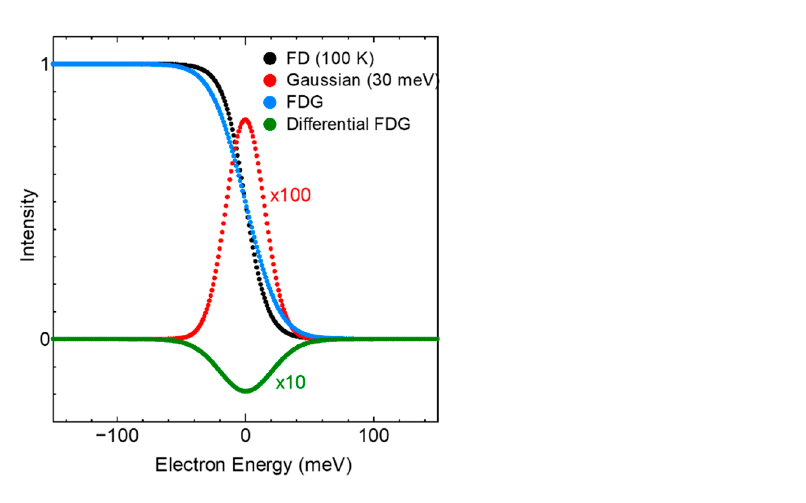
Figure 2. The broadening functions derived from FDG function of T = 100 K (black dots) and the convoluted original Gaussian functions (red lines). The spectrum widths W sp and the broadening widths of the original Gaussian functions Δ E ( a ) W sp = 200 meV, Δ E = 10 meV, ( b ) W sp = 200 meV, Δ E = 30 meV, ( c ) W sp = 200 meV, Δ E = 50 meV, ( d ) W sp = 400 meV, Δ E = 10 meV, ( e ) W sp = 400 meV, Δ E = 30 meV, ( f ) W sp = 400 meV, Δ E = 50 meV, ( g ) W sp = 600 meV, Δ E = 10 meV, ( h ) W sp = 600 meV, Δ E = 30 meV, ( i ) W sp = 600 meV, Δ E = 50 meV. 0